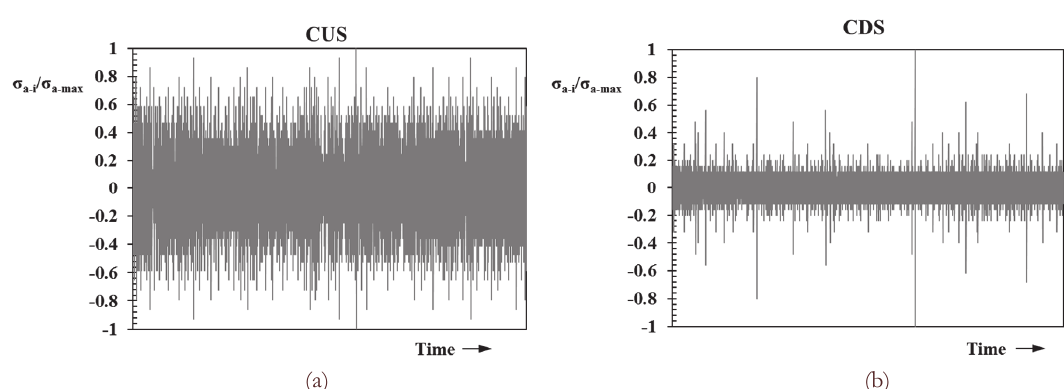
Figure 2 : Adopted load spectra (a) CUS and (b) CDS [3].